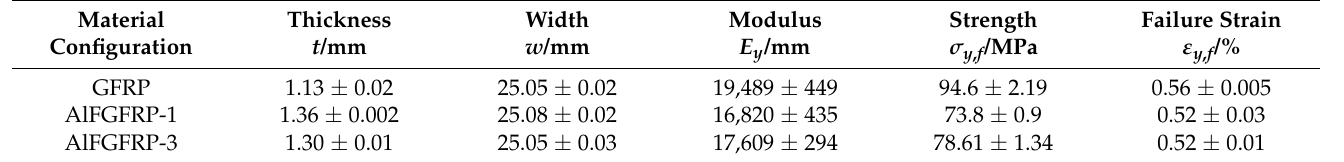
Figure 12. Stress–strain results of the reference laminate and aluminum-reinforced laminates containing work-hardened wires of different diameters tested under fiber-transverse tension: ( a ) original stress–strain plot showing the longitudinal and transverse stress–strain curves; ( b ) enlarged plot of the lower stress–strain region. Table 5. Results of the transverse tensile tests.